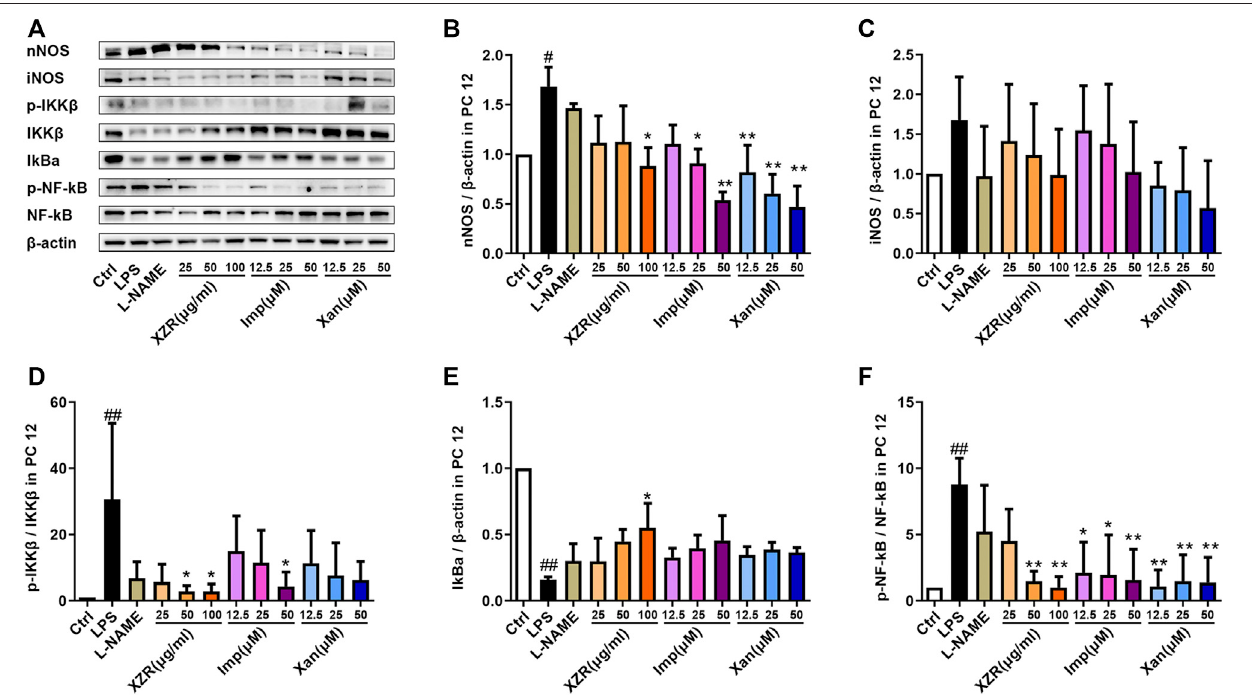
FIGURE9| IMPandxanthotoxininhibited theNOS/NF- κ Bsignaling pathway invitro . (A) RepresentativeWestern blotimagesofnNOS,iNOS, IKK β ,I κ B α ,and NF- κ B expression in LPS-treated PC12 cells. (B) Relative expression of nNOS. (C) Relative expression of iNOS. (D) Relative expression of IKK β . (E) Relative expression of I κ B α . (F) Relative expression of NF- κ B. Data are presented as the mean ± standard deviation, n = 3 – 5. # p < 0.05, ## p < 0.01 versus the control group, * p < 0.05, ** p < 0.01 versus the LPS group. LPS: lipopolysaccharide. IMP: imperatorin.